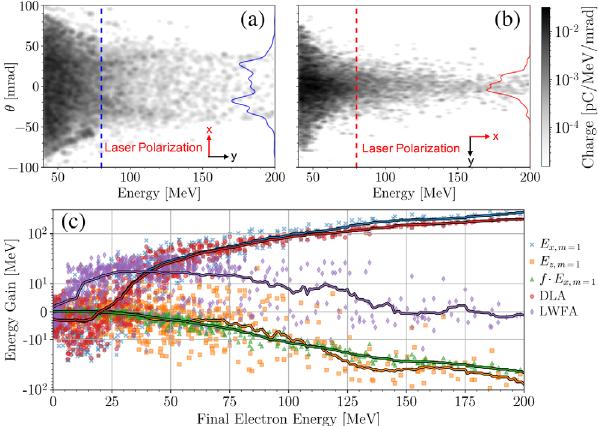
6. Simulated electron spectra dispersed (a) perpendicular and (b) parallel to the linear laser polarization direction. A line-out along the dashed line is plotted (solid line) to emphasize the “ horns ” of the dispersed beam. (c) The final energy gain due to different field components and mechanisms is shown for numerous tracked electrons (solid lines showing the mean within 20-MeV windows). All data is shown after 4.68 mm of